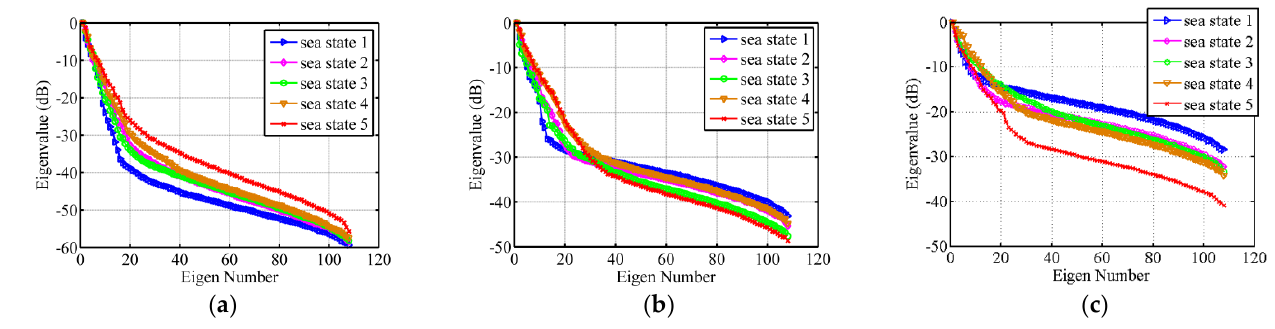
Figure 13. Comparison of the eigenvalue spectrum corresponding to different range gates: ( a ) #1 range gate; ( b ) #400 range gate; ( c ) #800 range gate.